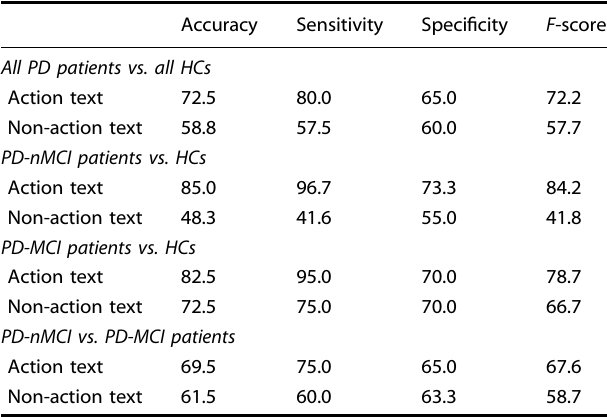
Table 3. GloVe embeddings: classi fi cation based on overall semantic structure.